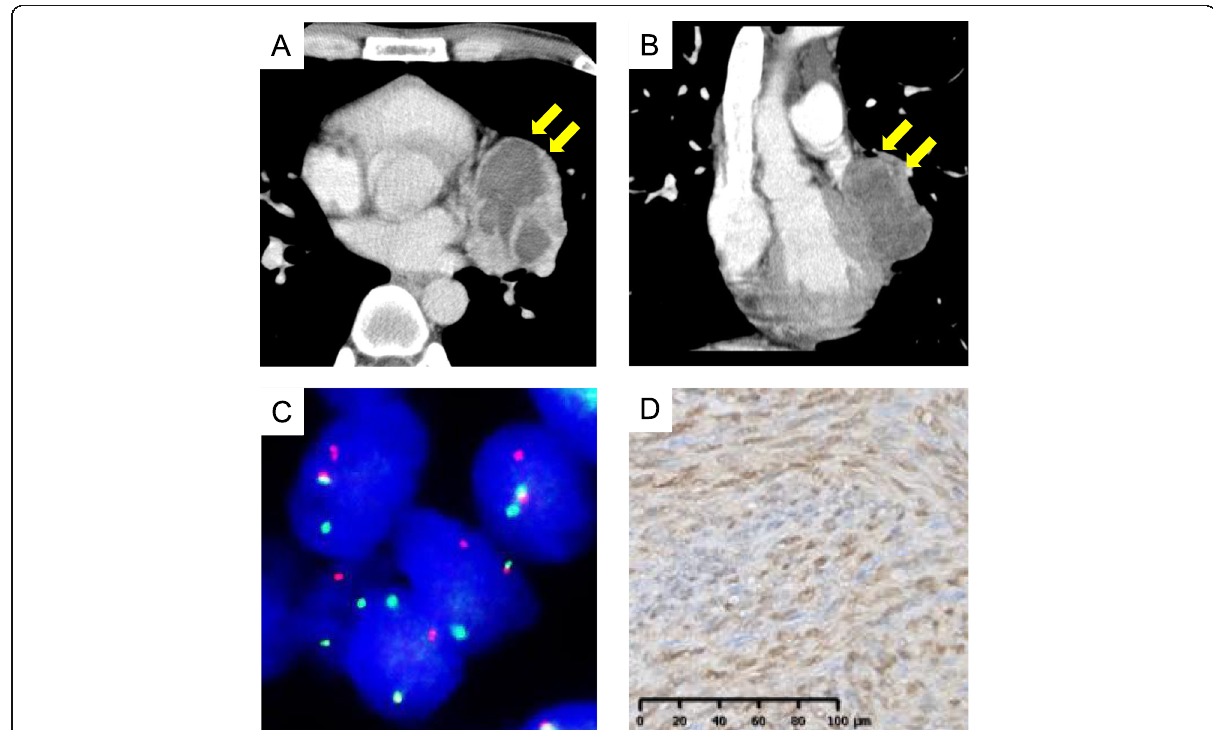
Fig. 2 Fluorescence in situ hybridization for SS18 rearrangement and immunostaining of SS18-SSX antibody in Case 2 (A)(B) The chest computed tomography (CT) scan shows a mediastinal mass of size 60 × 60 × 40 mm. (C) Image showing the results of fluorescence in situ hybridization for SS18 rearrangement. A disconnected SS18 gene can be seen. (D) The SS18-SSX fusion-specific antibody (E9X9V) is